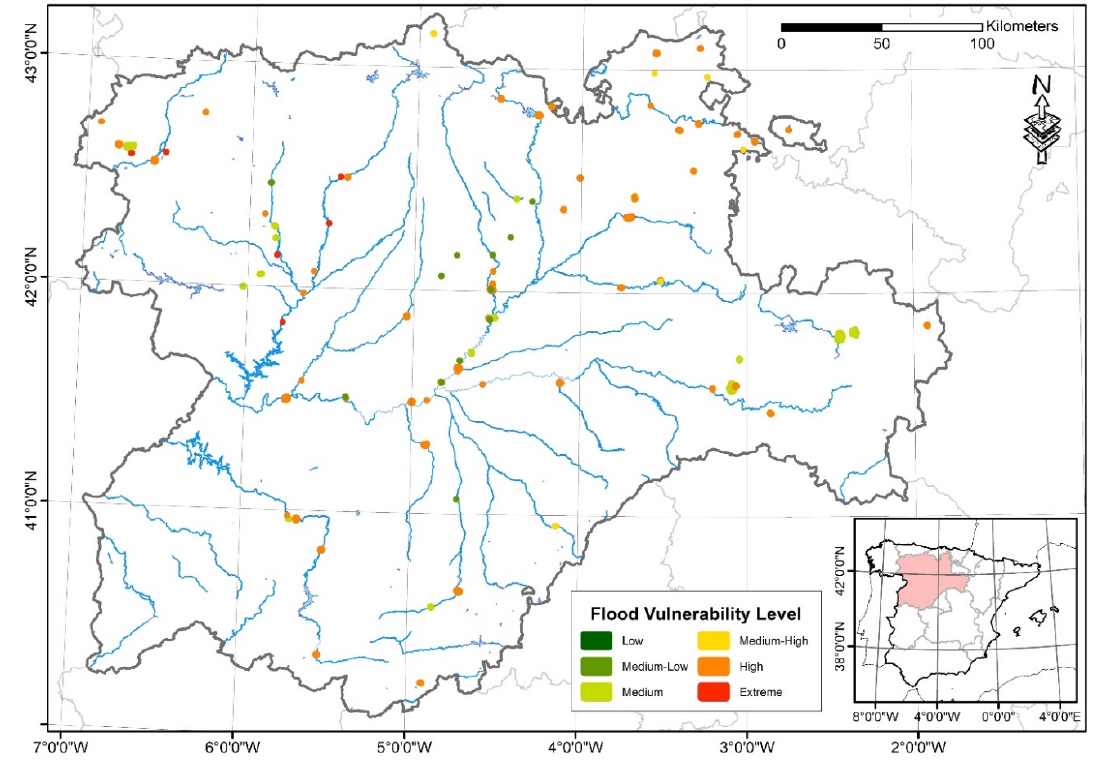
Figure 6. Spatial distribution of BICs in Castile and León region and their associated flood vulnerability level.